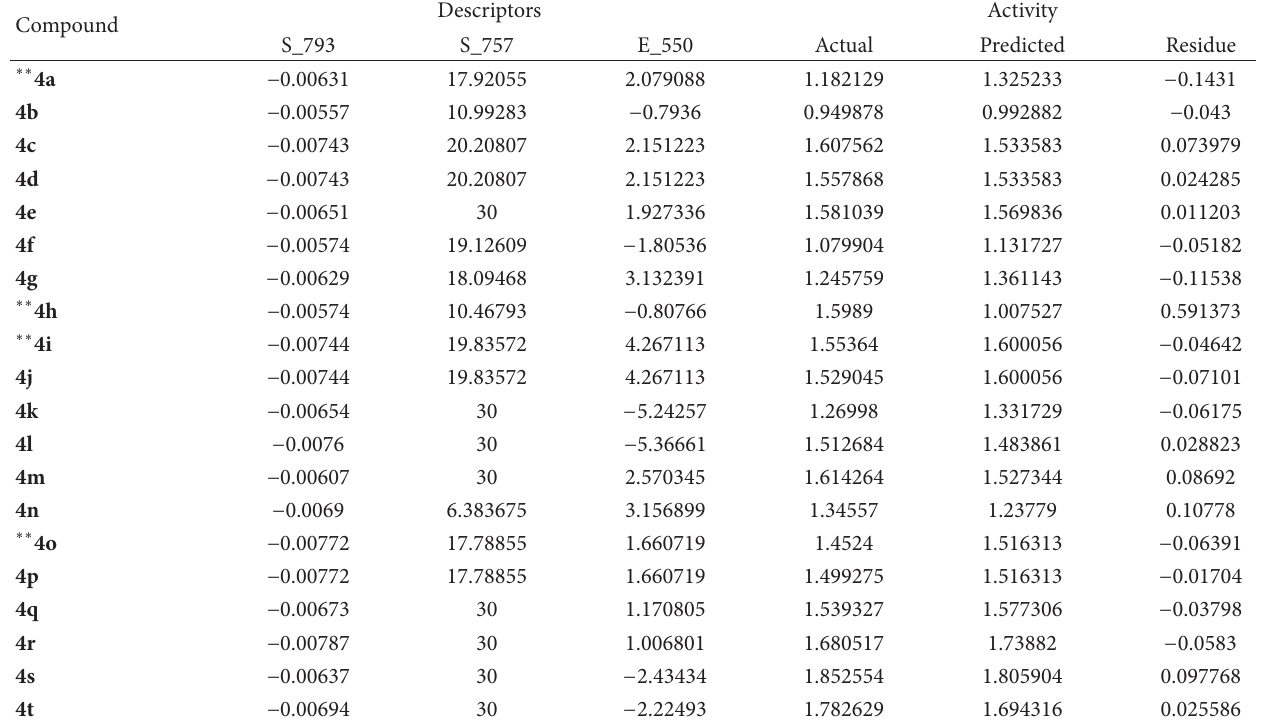
T 4: Selected descriptors, actual and predicted activity of tyrosinase inhibitors.